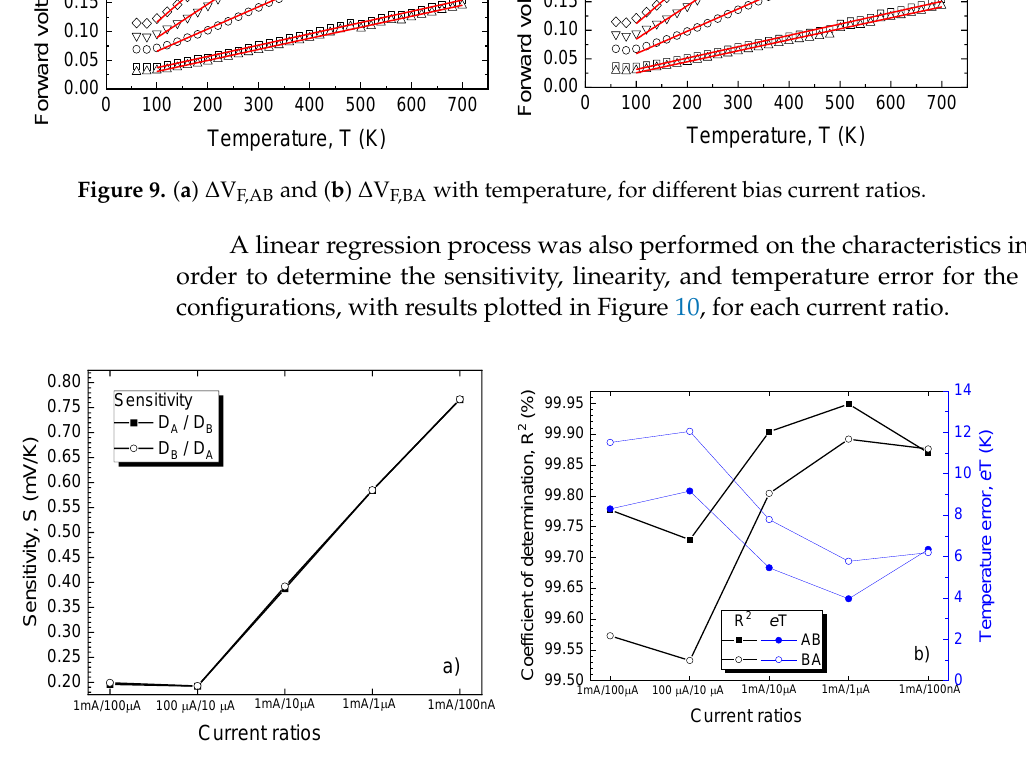
Figure 10. Sensitivity, coefficient of determination, and temperature error vs. diode current ratios for both differential configurations.